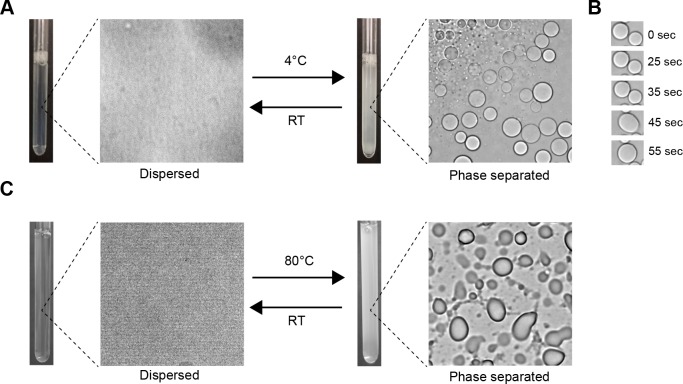
Visual confirmation of phase separation.(A) Test tubes containing transparent or turbid solutions of 1 mM FMR1 C-terminus (residues 445–632) along with their corresponding DIC microscopy images taken at room temperature or 4°C, respectively. (B) 1 mM FMR1 C-terminus forms droplets exhibiting liquid fusion properties at 4°C. (C) 40 µM solutions of Human Cytalomegalovirus pAP along with corresponding microscopy images taken at room temperature or 80°C, respectively.